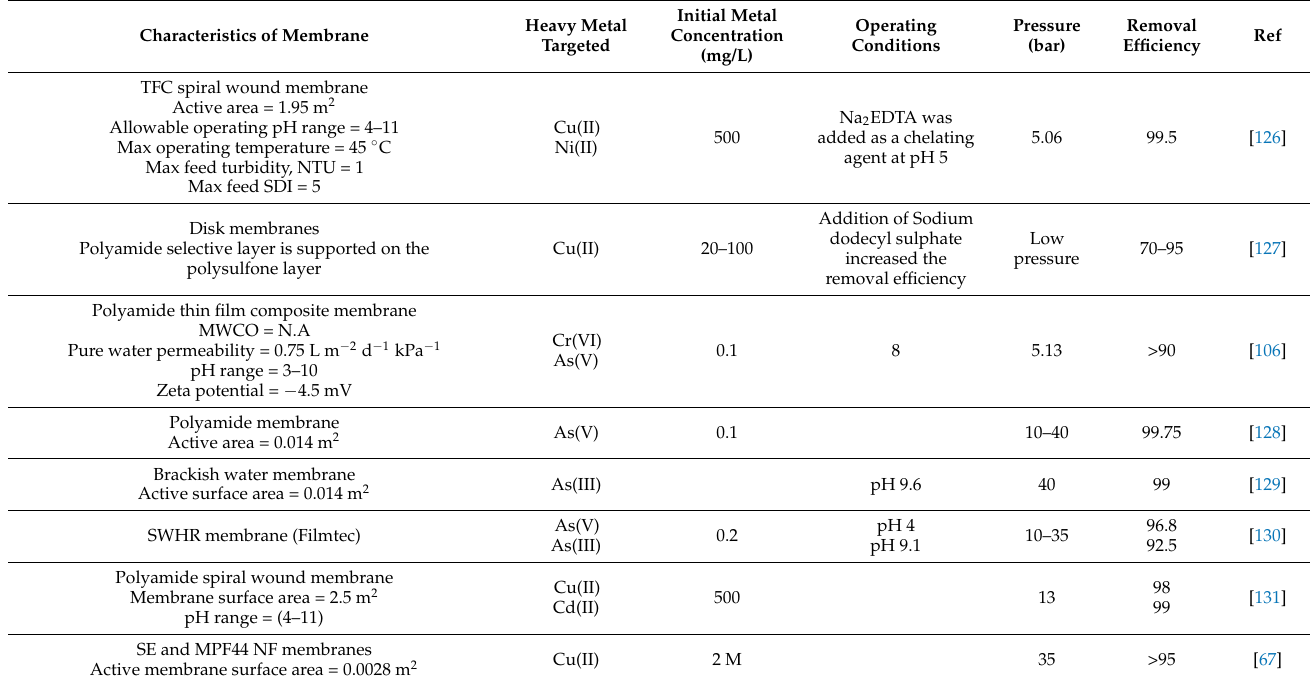
Table 4. Review of literature concerning application of RO in heavy metal